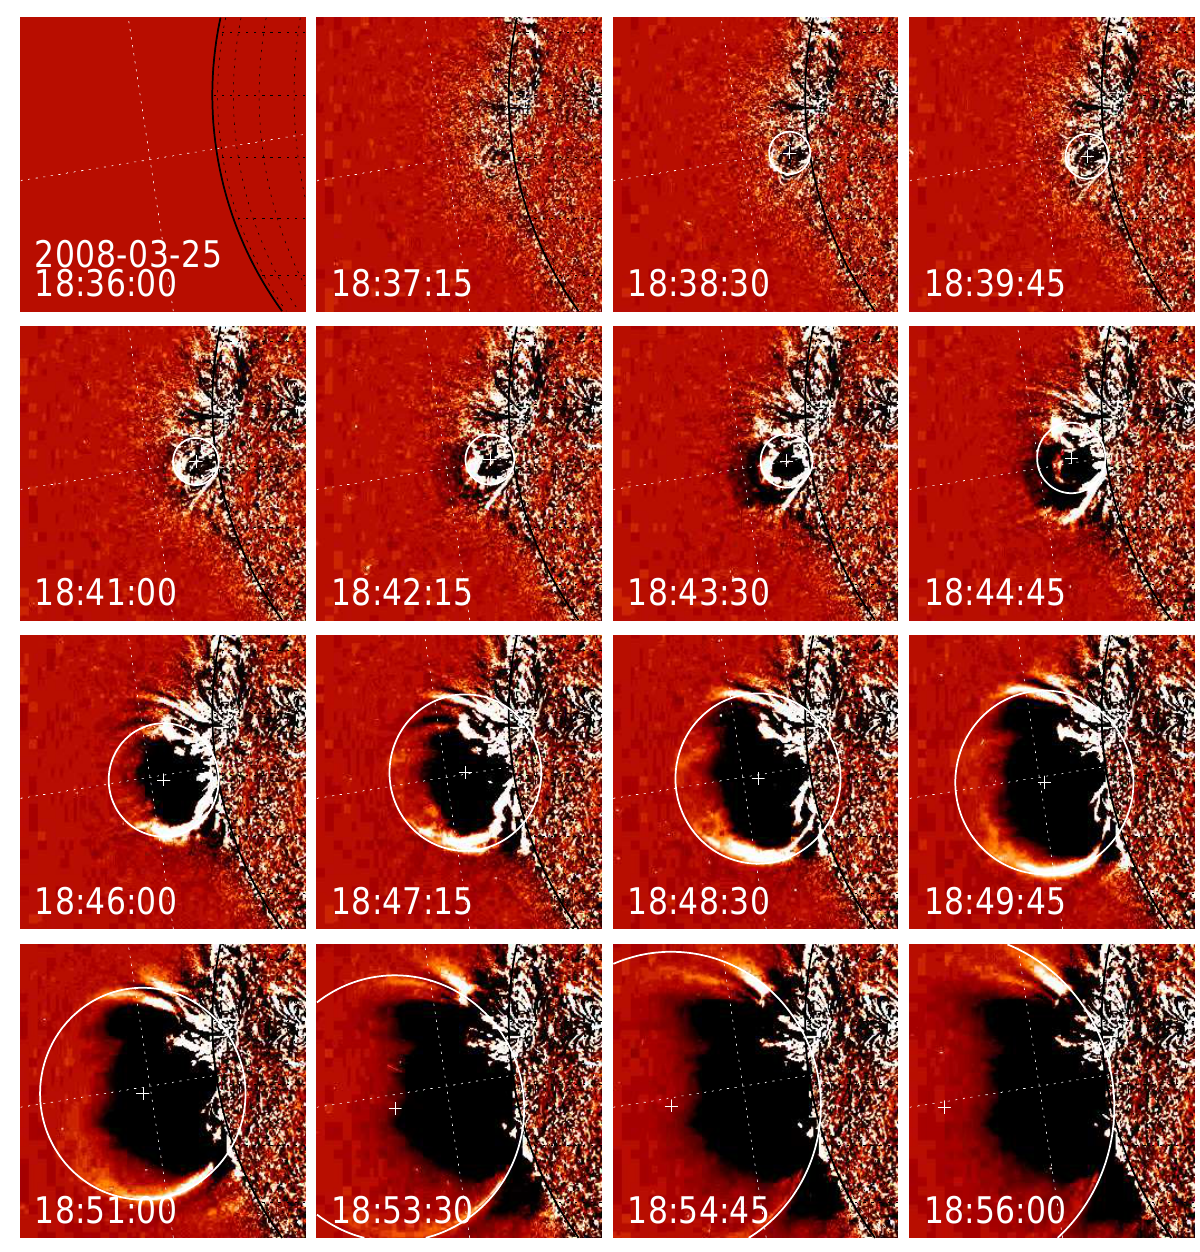
Fig. 2. Partial EUVI base-difference images from STEREO/A 171 ˚A during the time interval of 25 March 2008, 18:36–18:56UT (with the initial image at 18:36UT subtracted). The envelope of the lateral CME front is fitted with a circle. The dashed lines mark the locations where cross-sectional brightness profiles are extracted for fitting, shown in Fig.